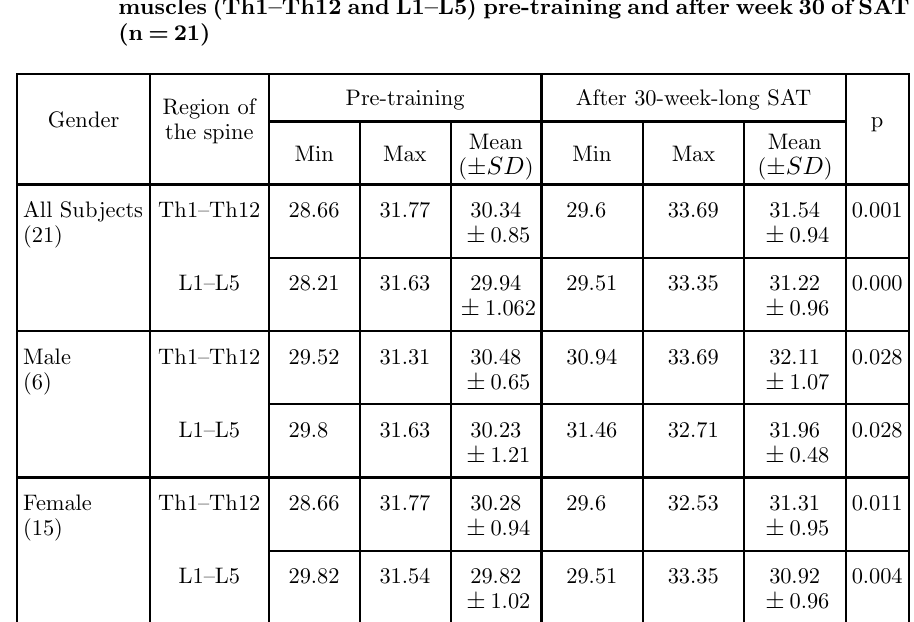
Table 4. Descriptive statistics of differences in the temperature of deep spine muscles (Th1–Th12 and L1–L5) before the 1 st vs after the 1 st SAT, and before the 30 th vs after the 30 th SAT (n = 21) Before 1 st vs after 1 st SAT Before 30 th vs after 30 th SAT Region of Gender p the spine Mean Mean Min Max Min Max ( ± SD ) ( ± SD ) All Subjects